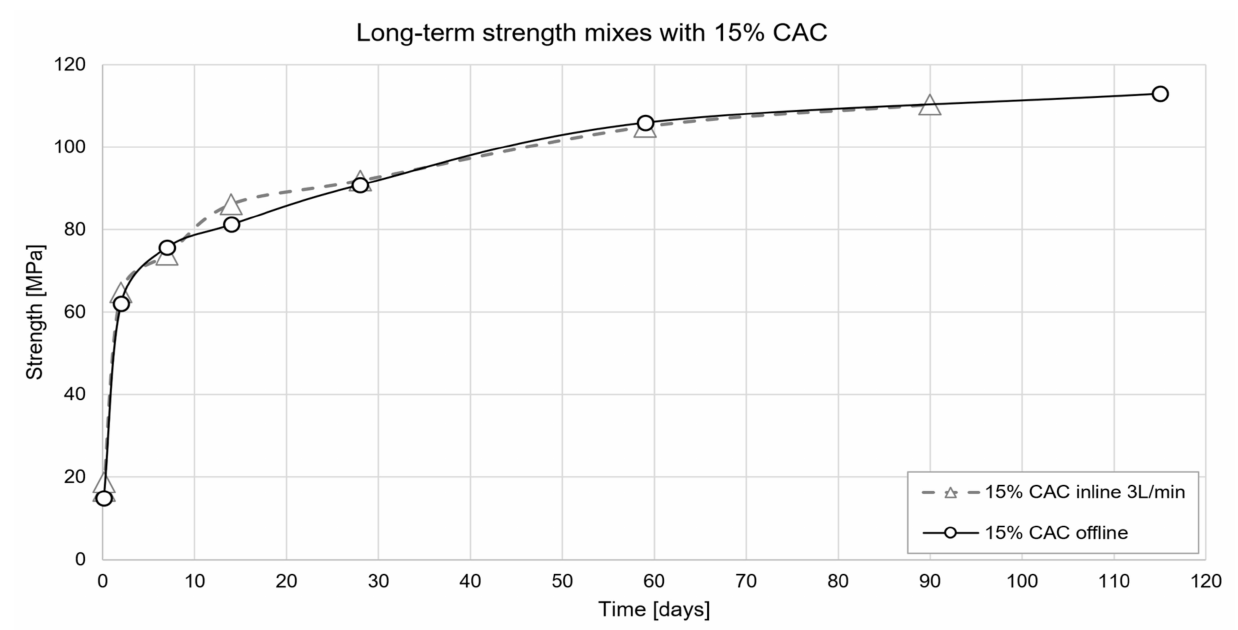
Figure 7. Strength evolution of the accelerated mixes prepared “inline” and “offline”.